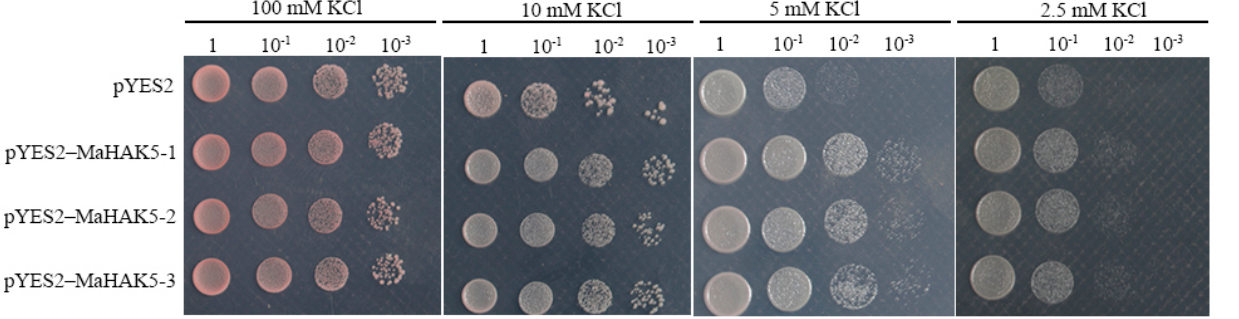
Figure 3. Functional characterization of MaHAK5 in yeast. R5421 expressing MaHAK5 grew at a lower K + concentration.